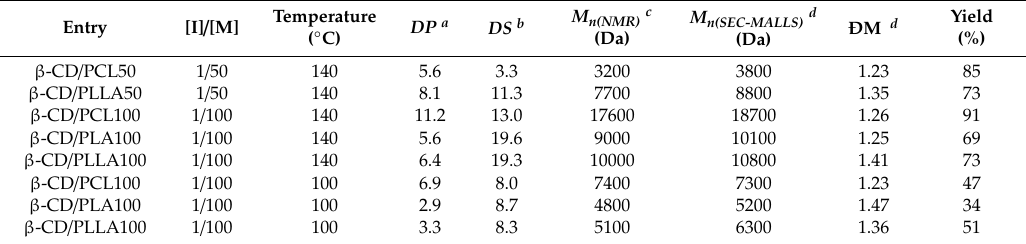
Table 1. The parameters of the ring-opening polymerization (ROP) of d , l -lactide (LA), l , l -lactide (LLA), and ε -caprolactone (CL) initiated by β